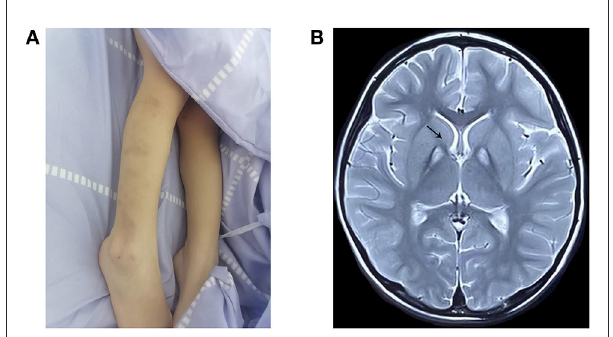
FIGURE2 Molecular analysis of PANK2 variants. (A) PANK2 gene sequencing of the patient and his parents. The patient carried compound heterozygous PANK2 gene mutations of c.1213T > G and c.1502T > A; the father carried c.1502T > A, and the mother carried c.1213T > G. Arrow indicates the location of variants. (B) Multiple sequence alignment of PANK2 from different organisms. Residues are colored based on conservation. The white letters in red boxes represent the highest conservation-grade, black letters in yellow boxes represent the second-highest conservation grade, and no color indicates the least conserved grade. The variants p.Tyr405Asp and p.Ile501Asn are indicated by a purple triangle.